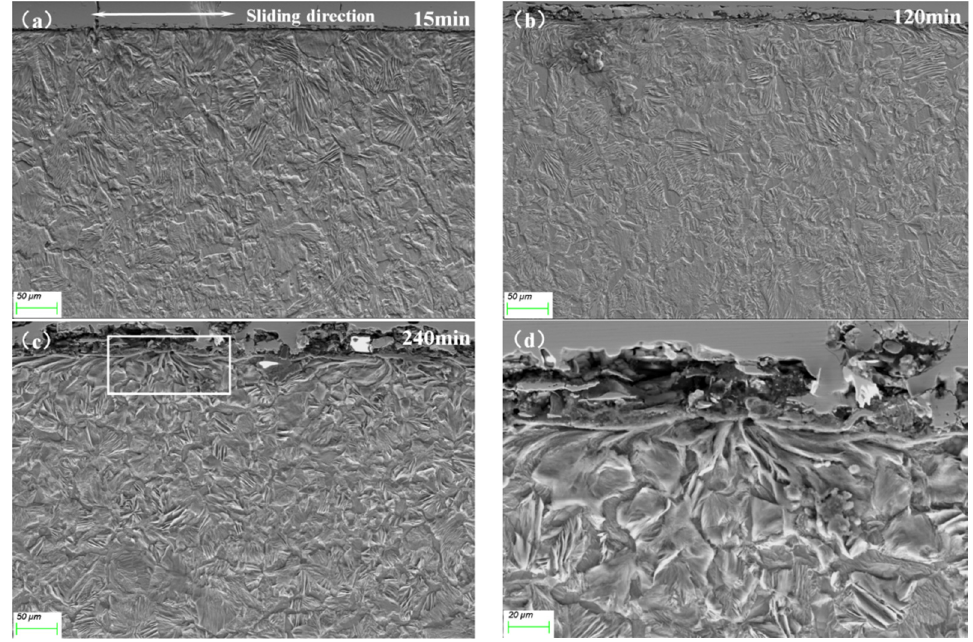
Figure 7. Cross-sectional microstructures of 40Cr pins after reciprocating sliding: ( a ) 15 min, ( b ) 120 min, ( c ) 240 min, ( d ) the magnified region in ( c ).